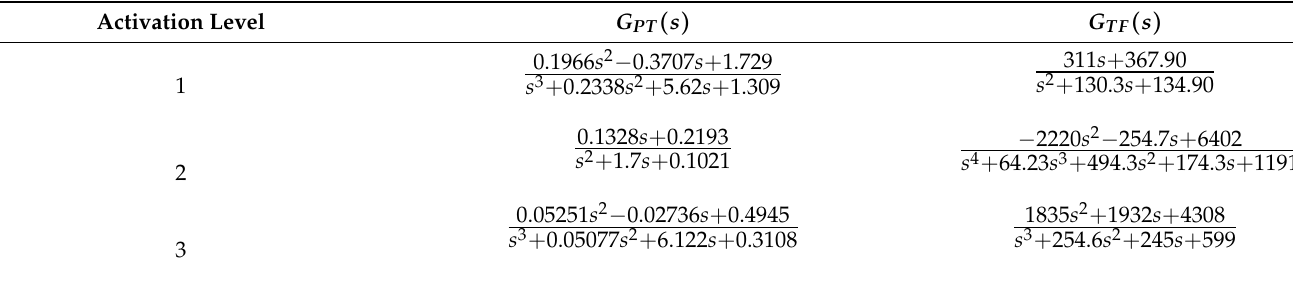
Table 8. Frequency domain transfer functions for the power–temperature relationships G PT ( s ) and the temperature–force relationships G TF ( s ) for each activation level of the actuator.